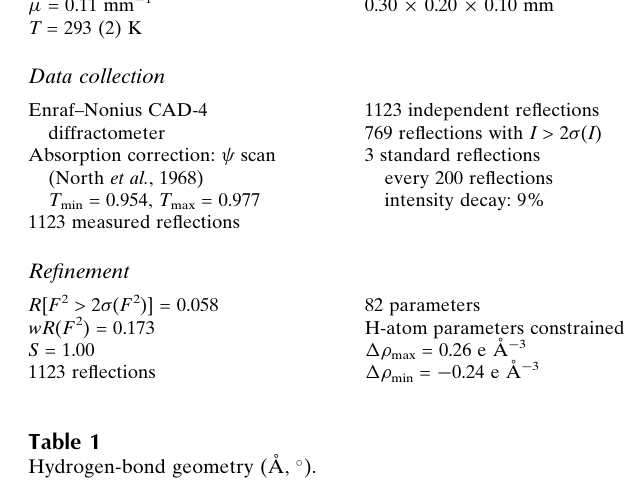
Hydrogen-bond geometry (A˚ , (cid:2)